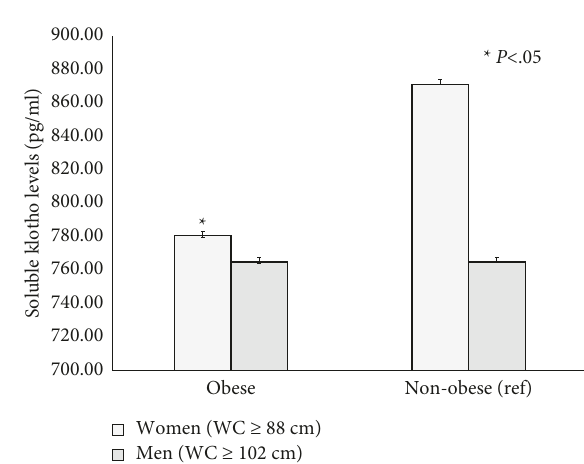
Figure 2: Sex-specific abdominal obesity prevalence and serum soluble klotho levels.